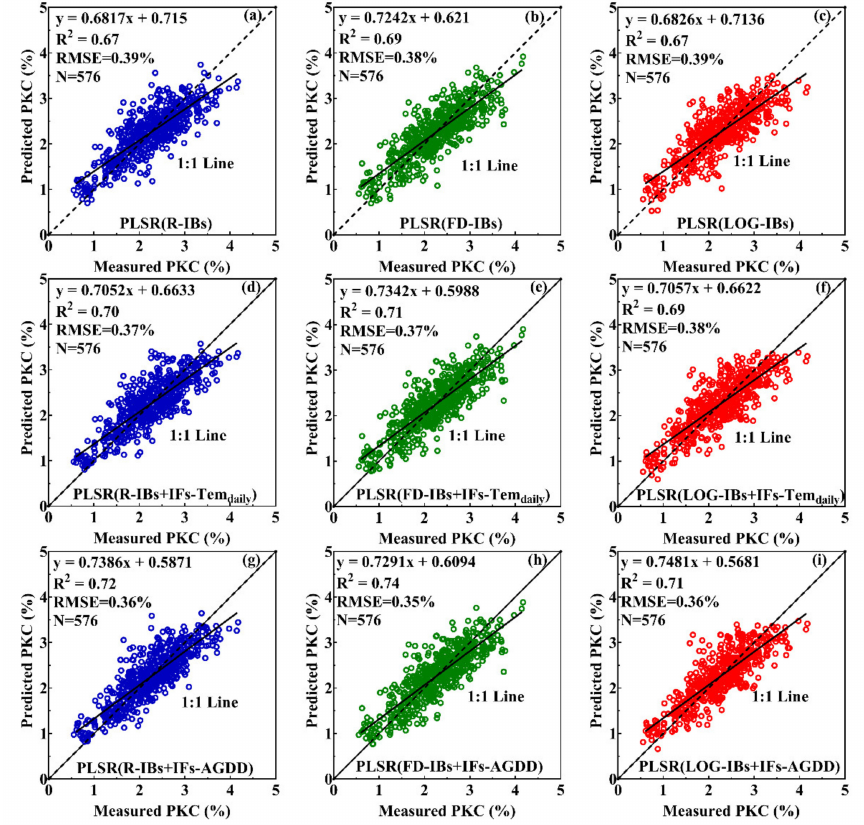
Figure 8. Relationships between the measured plant potassium content (PKC) and predicted PKC with the calibration dataset using partial least-squares regression (PLSR) based on important bands (IBs) of reflectance spectra (R-IBs) ( a ), IBs of first derivative spectra (FD-IBs) ( b ), IBs of reciprocal logarithm-transformed spectra (LOG-IBs) ( c ), R-IBs + important meteorological factors (IFs) including daily average temperature and humidity (IFs-Tem daily ) (R-IBs + IFs-Tem daily ) ( d ), FD-IBs + IFs- Tem daily ( e ), LOG-IBs + IFs-Tem daily ( f ), R-IBs + IFs including accumulated growing degree day (AGDD) and daily average humidity (IFs-AGDD) (R-IBs + IF-AGDD) ( g ), FD-IBs + IFs-AGDD ( h ), and LOG-IBs + IFs-AGDD ( i